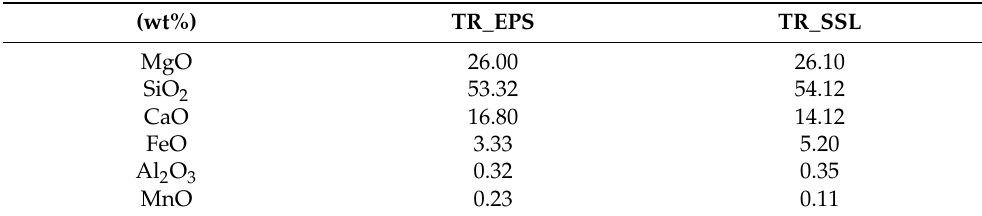
Table 2. Trace element concentrations (ppm) in the studied tremolite asbestos from Episcopia